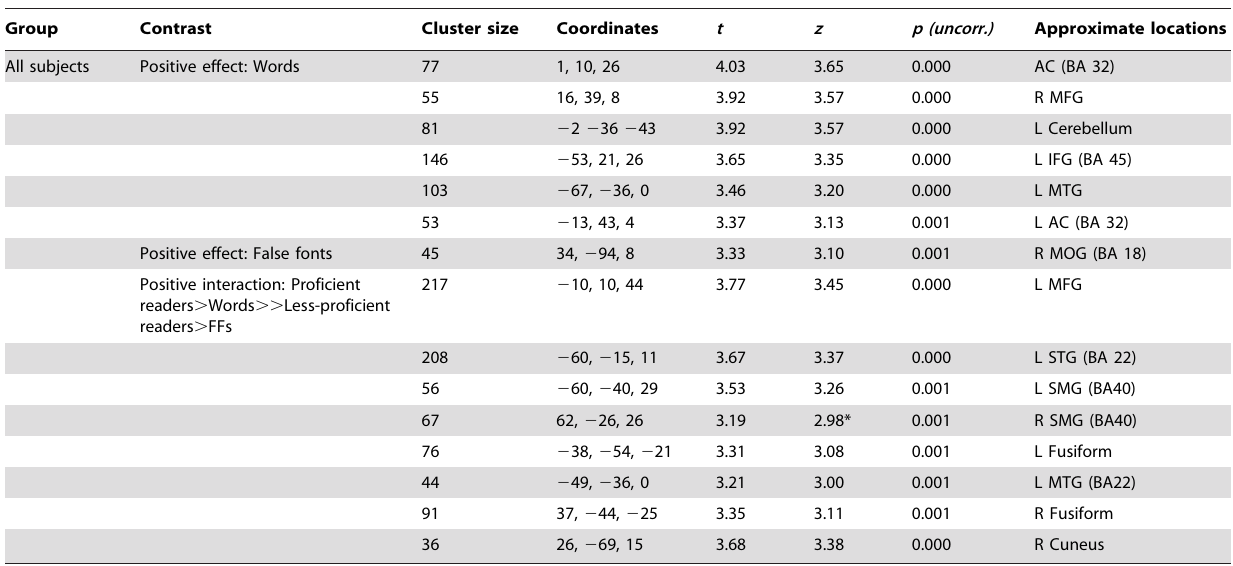
Table 1. List of all activation foci in group analysis.